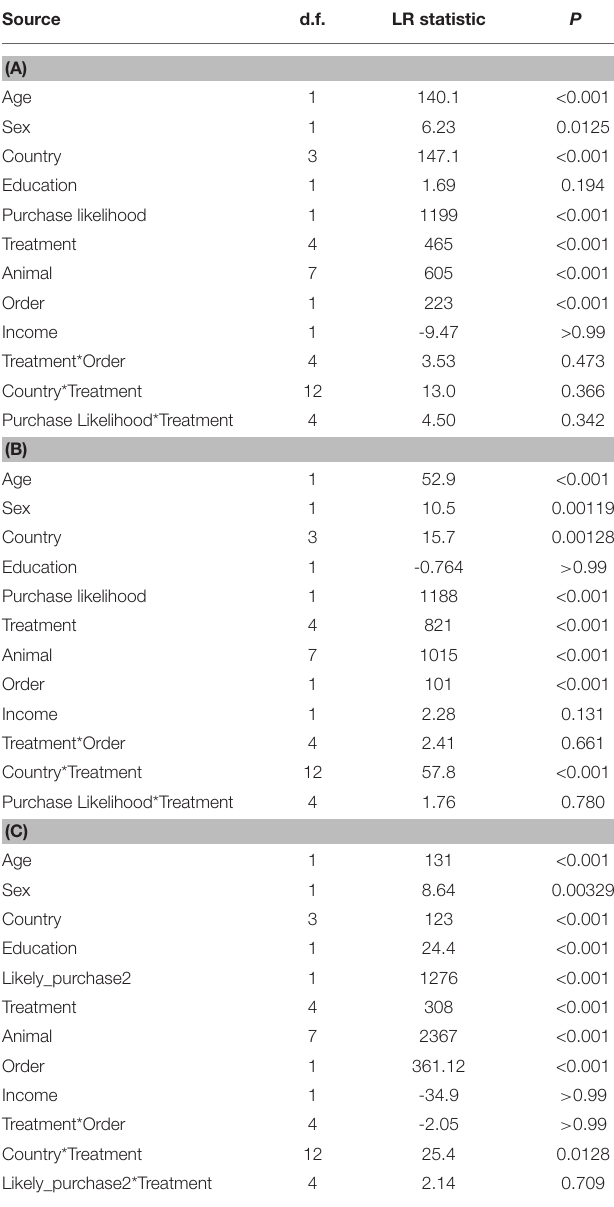
TABLE 3 | Factors affecting respondents’ selected desire to purchase a given pet, for (A) mammals (B) birds (C) reptile.